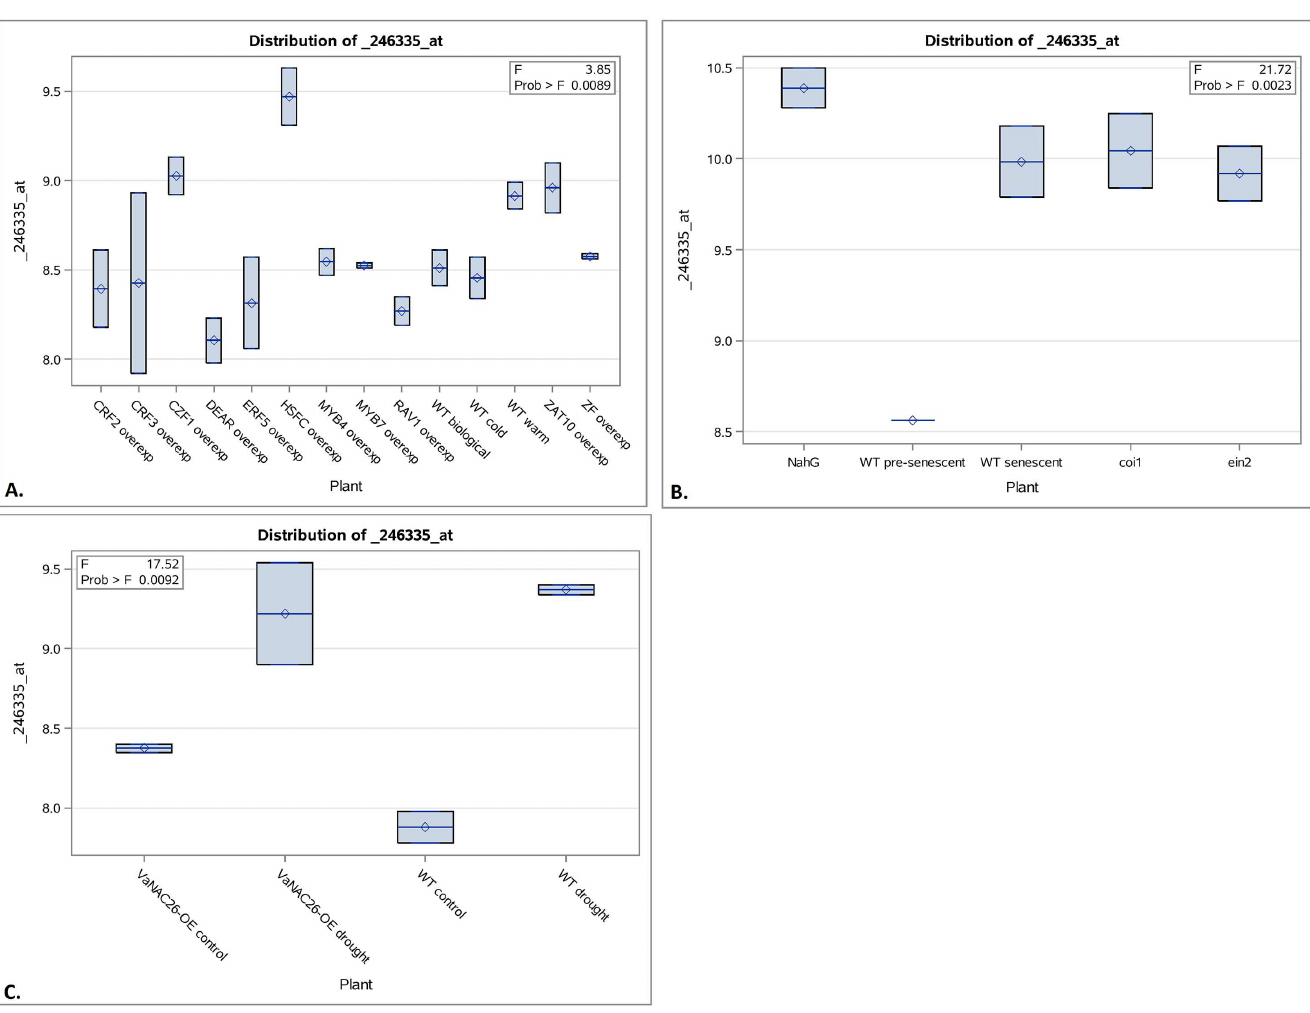
Fig 1. Comparisonof PAO expression levels amongplantlinesin differentmicroarray datasets. An ANOVA was performed to cross-compare PAO expression levels and found significant differences amongplant lines in the GSE55907,GSE5727, and GSE72050 microarray datasetsat the P < 0.05 level in normalvs. pre-freezing treatment( A ),pre-senescence vs. duringsenescence ( B ),and drought vs. well-water conditions ( C ),respectively. Box plots displayed lower to upperquartileswith central horizontallines representing median,diamonds representing mean,end lines representing maximumand minimumvalues, and circles representing outliers.Furtherdetailson the degrees of freedom,mean squares, correlationcoefficients, and ANOVA detailsare provided in S1–S3